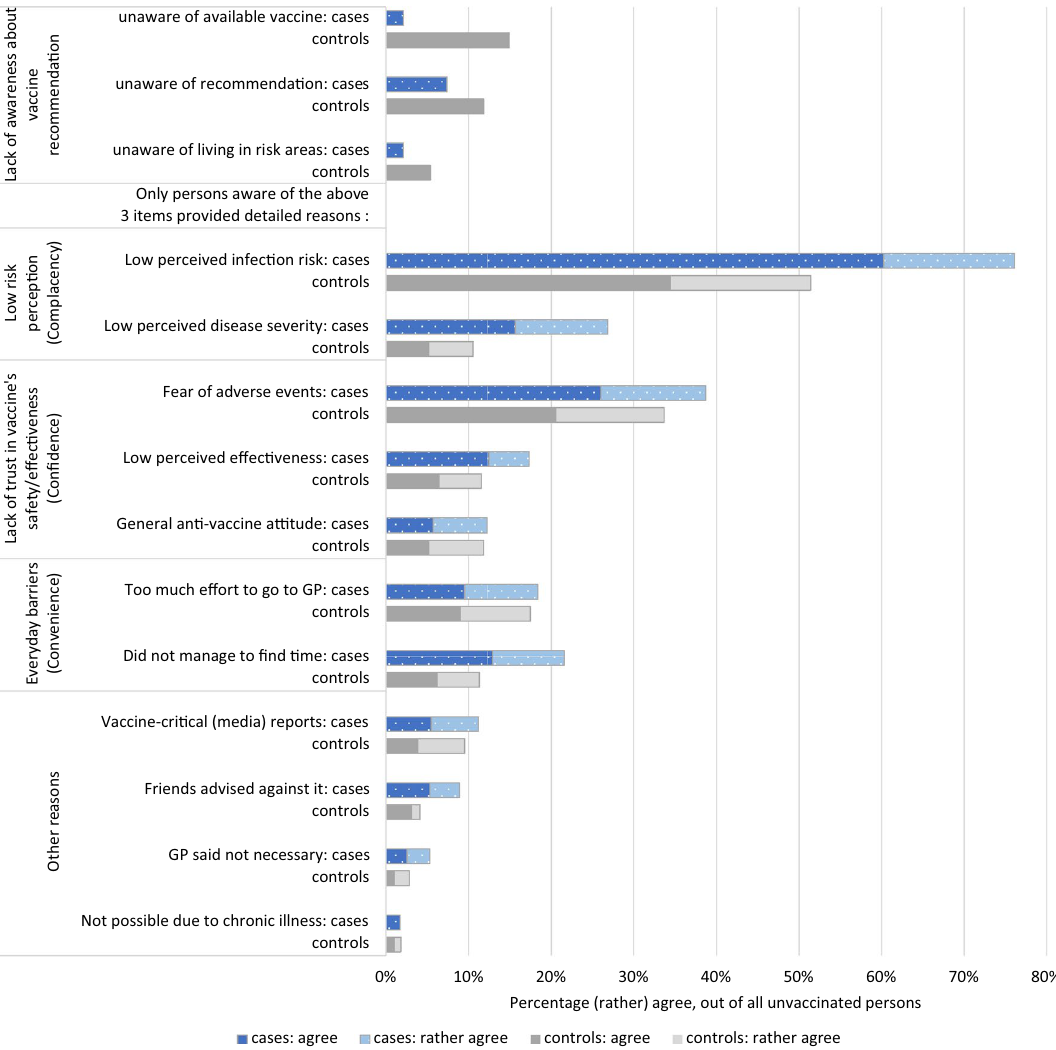
Figure 1. Vaccination barriers reported by unvaccinated cases ( n = 473) and controls ( n = 389) living in or visiting TBE risk areas. Multiple answers were possible, except on the first 3